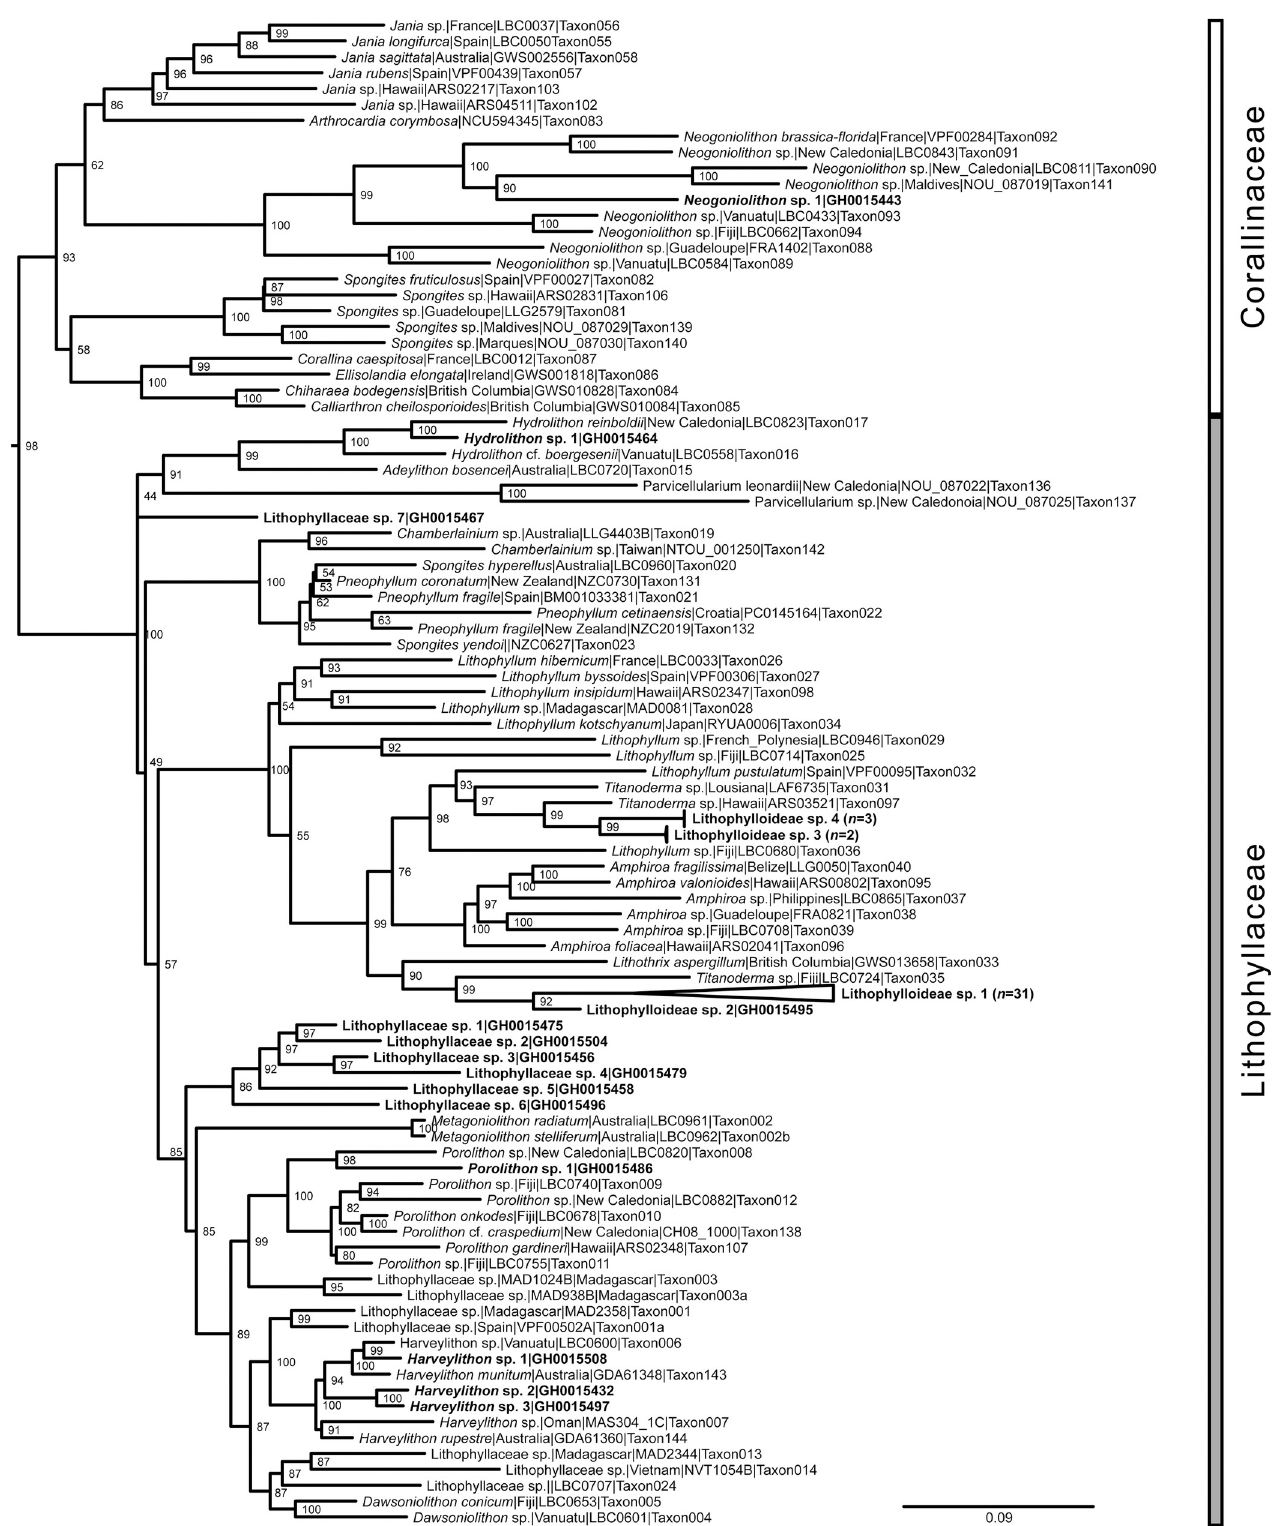
Fig 2. Seven-gene concatenated maximum likelihood phylogeny for the 17 Corallinales species from the recruitment tiles (boldface font) and reference sequences from Pe ñ a et al. [68]. GH numbers are the specimens’ voucher numbers in the Guam Herbarium (GUAM). The tree was inferred by maximum